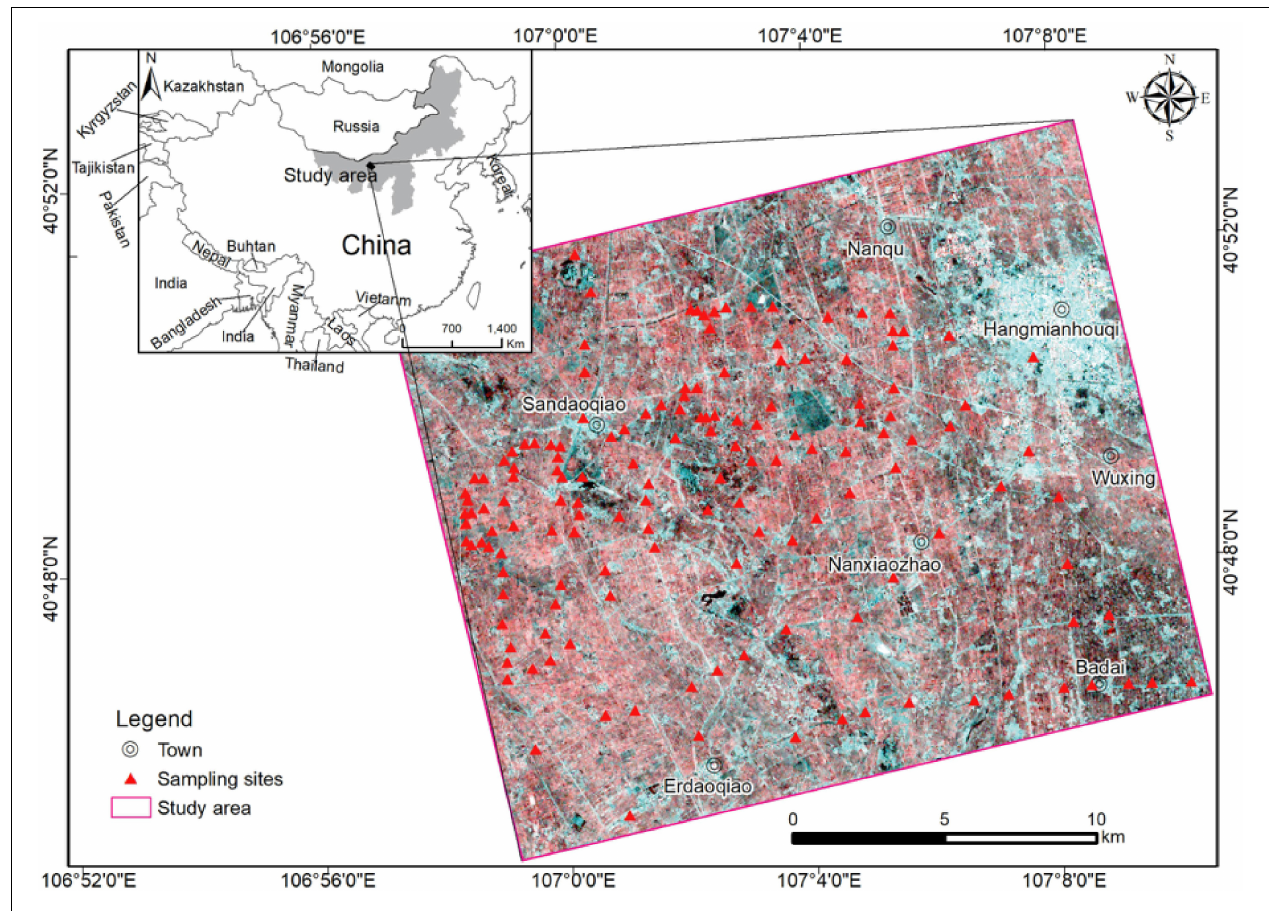
FIGURE 1 | Location of study area and 147 sampling plots in Hetao Plain, Inner Mongolia from Radarsat-2 scene.